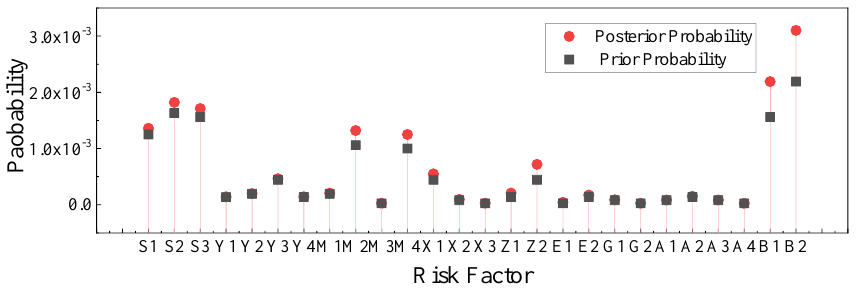
Figure 11. Probability updating for disconnect failure.